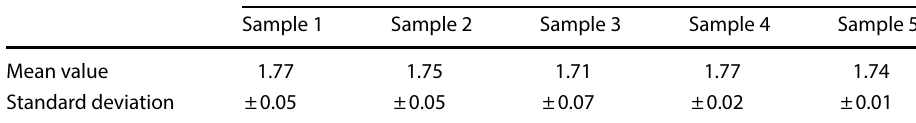
Table 6 Evaluation of filament diameter